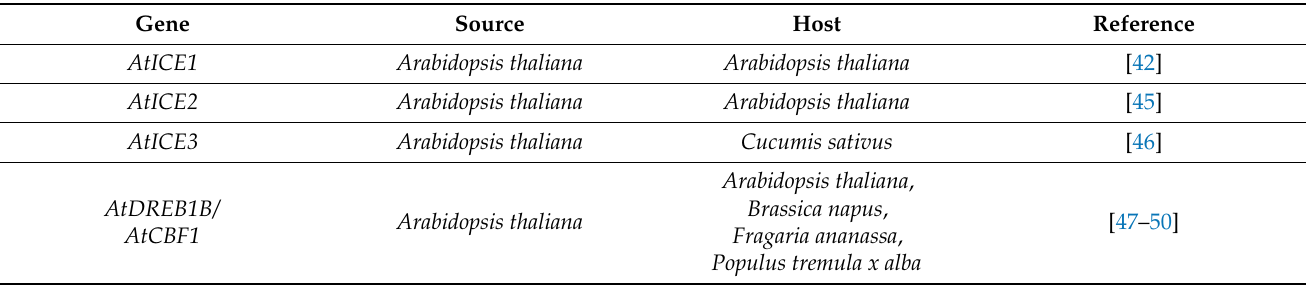
Table 1. ICE and DREB1A/CBF identified from the model plant Arabidopsis thaliana and crop plants are validated within the same host plant or other plants for cold tolerance or chilling stress